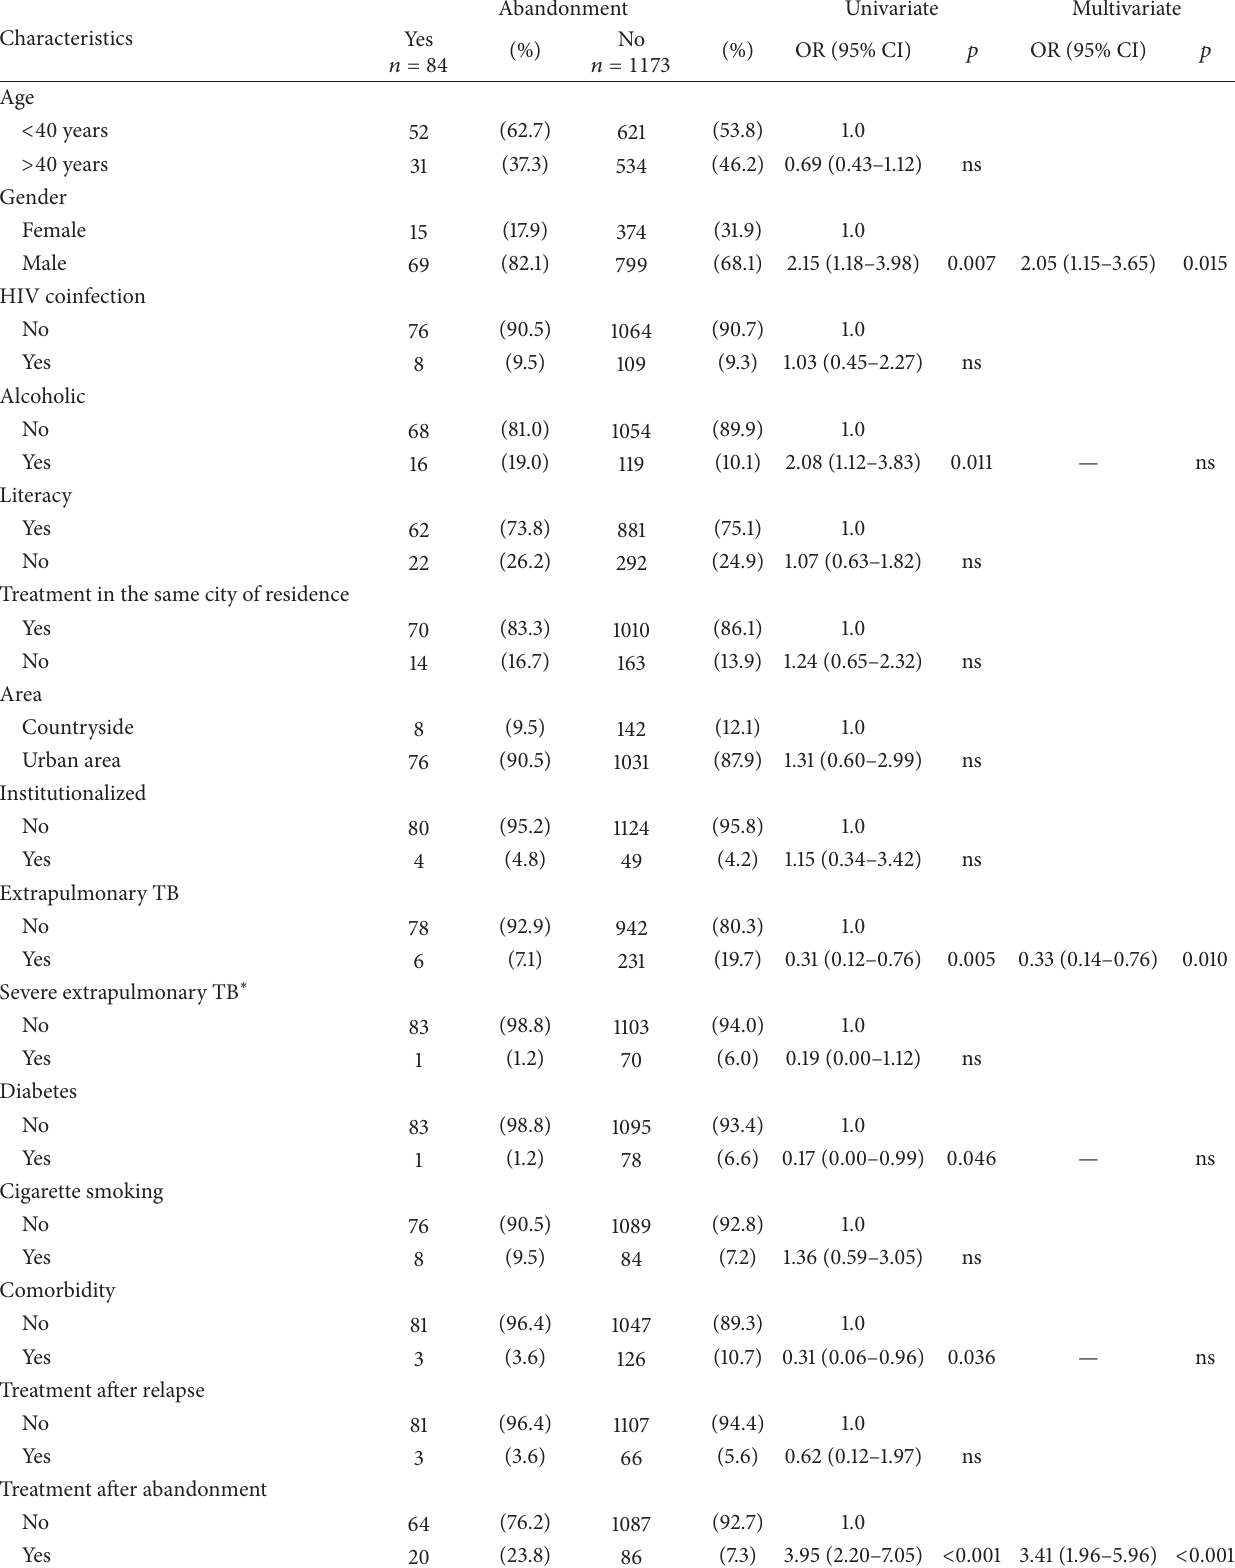
Table 2: Univariate and multivariate analyses of risk factors associated with TB treatment